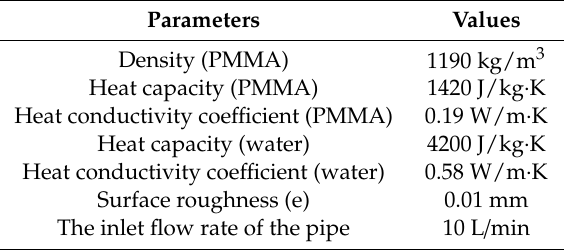
Table 1. Parameters for the simulation